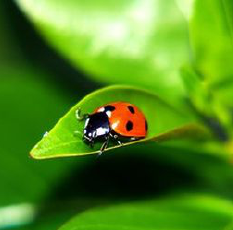
Figure 1. The example of a focused image.